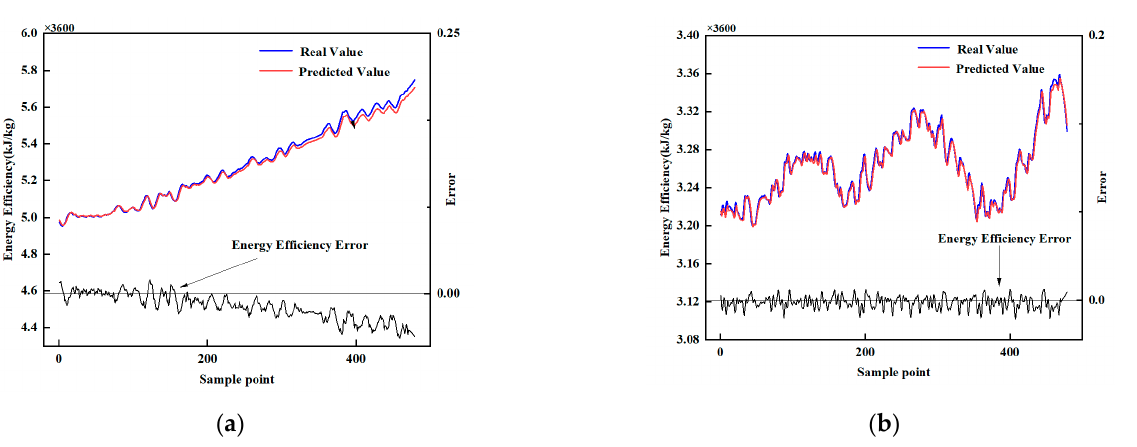
Figure 14. Product energy-efficiency prediction of working condition 3. ( a ) Prediction of energy efficiency of atmospheric two-line products. ( b ) Prediction of energy efficiency of vacuum two-line products.